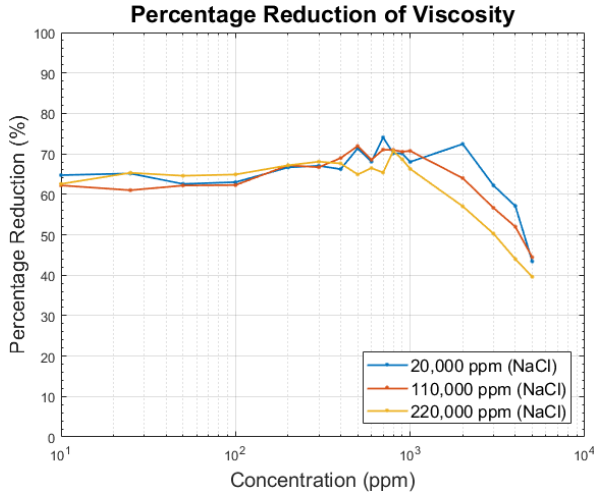
Figure 14: Percentage reduction of viscosity of the solution mea- sured at 20,000 ppm (NaCl) and 23 ∘ C, for all xanthan gum concen-